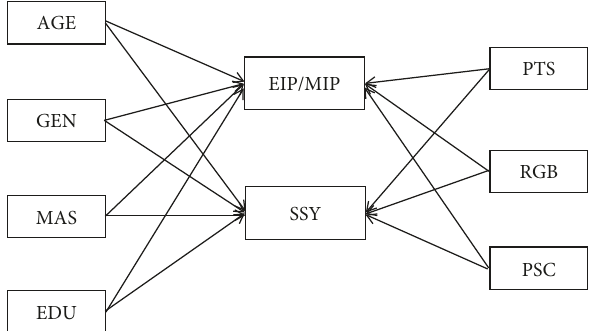
Figure 1: “Sense of security” path analysis model. Table 1: Variable